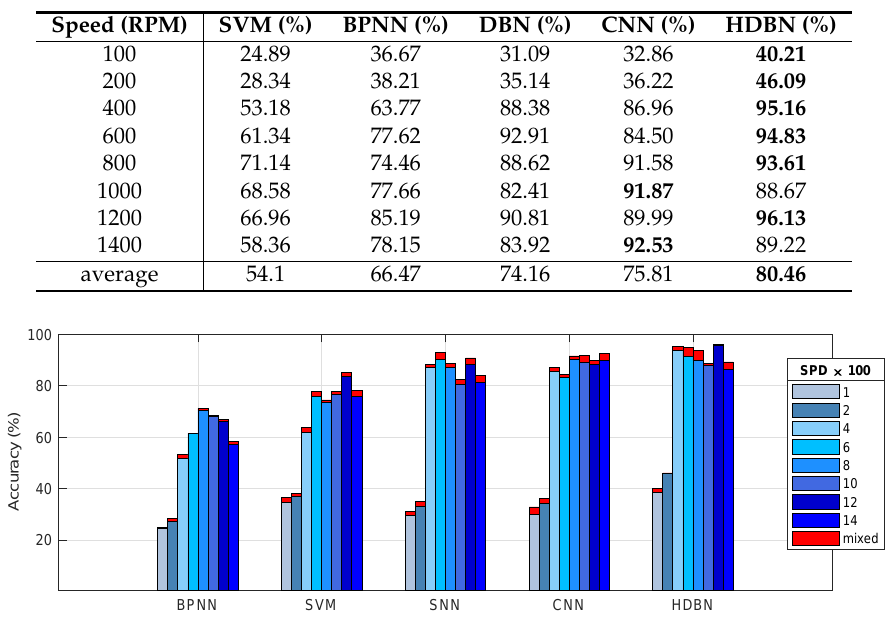
Table 6. Comparison of different models under test 6 .